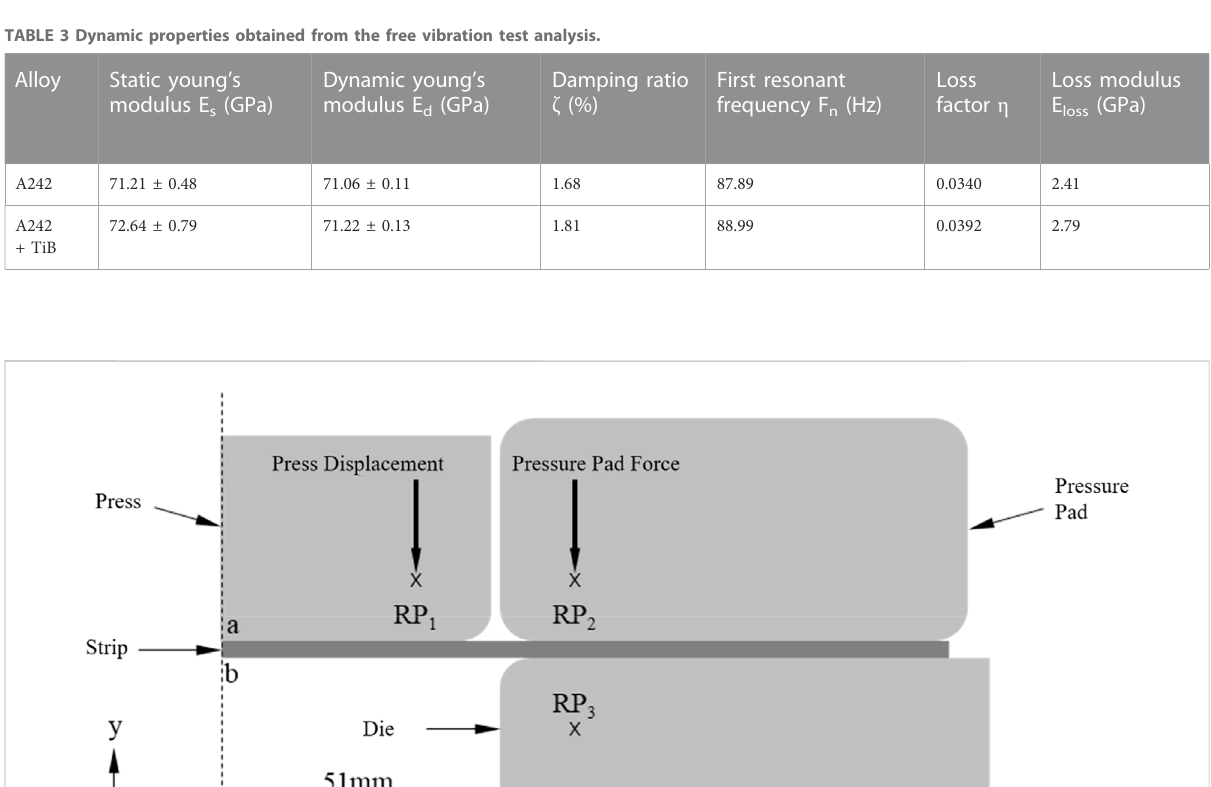
size, which leads to a fi ner distribution of the second phases (i.e., the intermetallic phases) surrounding the dendrites uniform distribution of elements in the microstructure by creating heterogeneous nucleation sites with Ti 2 and Al 3 Ti